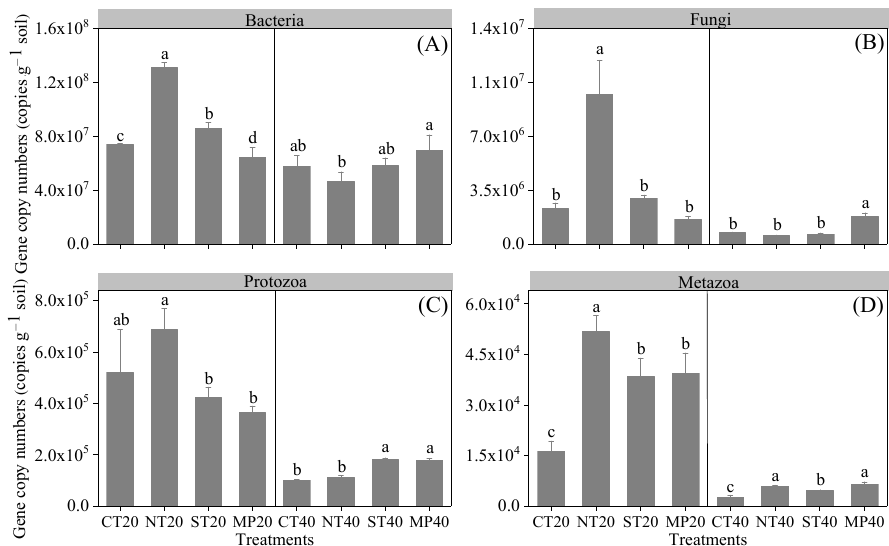
Figure 2. Changes in soil microbial (bacteria and fungi) and faunal (protozoa and metazoa) gene abundance (gene copy numbers). ( A ) Bacteria, ( B ) Fungi, ( C ) Protozoa, and ( D ) Metazoa. CT20, Ro- tary and ridge tillage at 0–20 cm depth; NT20, No-tillage at 0–20 cm depth; ST20, Subsoil tillage at